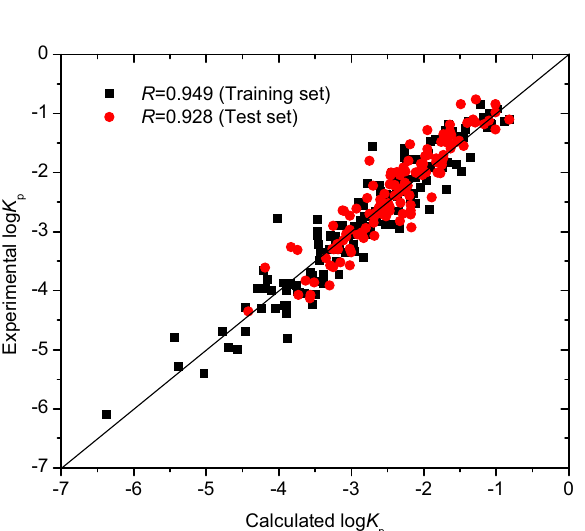
Figure 4. Plot of experimental versus predicted log K p with Eq. (14), generated by OriginPro 7.5